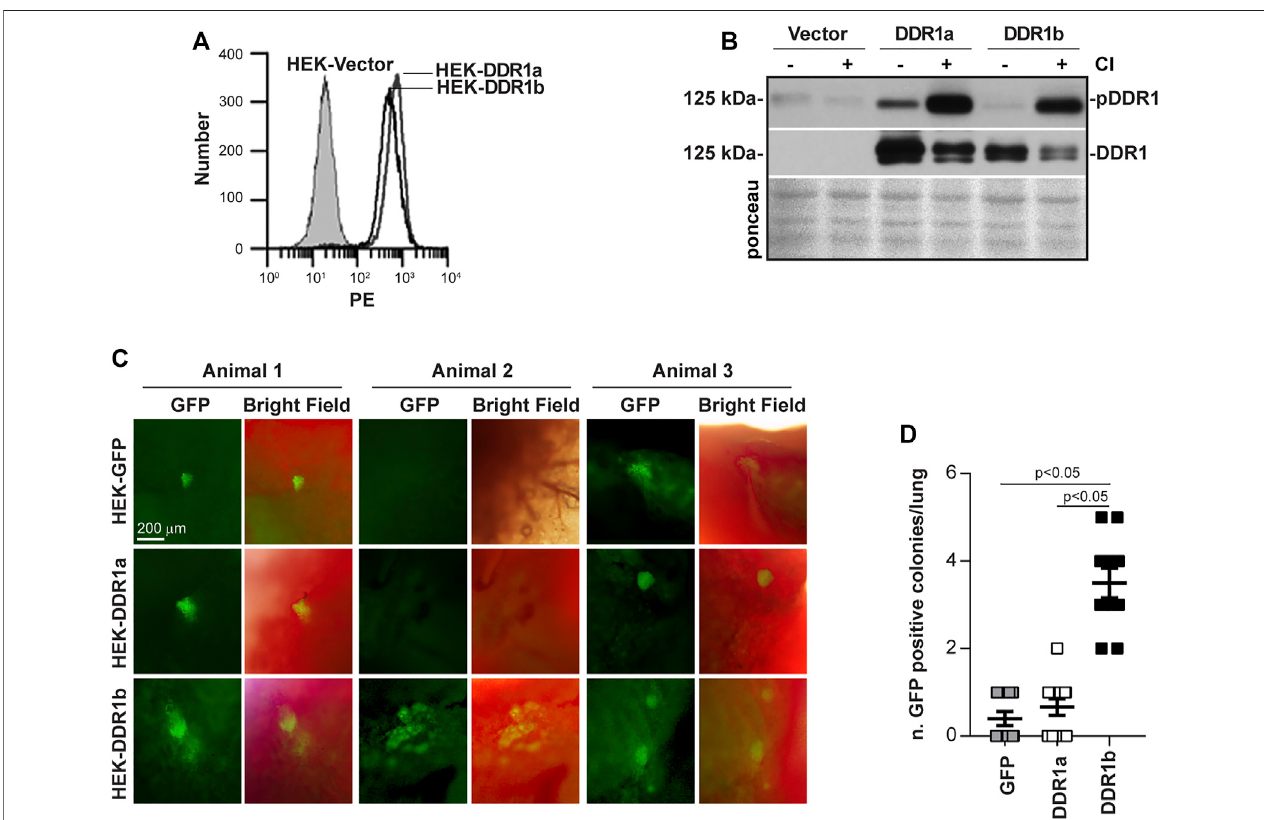
FIGURE 1 | DDR1b supports lung colonization in vivo . (A) HEK cells were transfected with either empty vector, DDR1a or DDR1b cDNAs and cell populations expressing comparable levels of DDR1a and DDR1b were sorted by FACS. PE, phycoerythrin. (B) Western blot analysis of phosphorylated DDR1 (anti-pY792 in the activation loop of the receptor) and total DDR1 levels in HEK-Vector, HEK-DDR1a and HEK-DDR1b cells treated with acetic acid (20 mM) or collagen I (50 µg/ml in 20 mM acetic acid) for 90 min (C) GFP-expressing HEK-Vector, HEK-DDR1a or HEK-DDR1b cells were injected in nude mice intravenously and 2 weeks later the numberofGFPpositivecoloniesinthelungswasevaluatedbyplacingthelungunderanepi fl uorescencemicroscope.Imagesoflungsfrom3animalsforeachgroupare shown. (D) Symbols represent number of colonies per lung, whereas bars are mean ± SEM. Statistical analysis: One-way ANOVA followed by Tukey ’ s multiple comparison